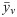
Overview of the available data and our analysis approach.(A) Schematic representation of the bicistronic reporter construct used in [21] with eGFP (green) expression used to measure IRES activity of variable sequences (gray), and constitutively expressed mRFP used to control for unique genomic integration. To capture context effects, in our analyses the assayed variable sequences (thick gray) were extended to include flanking regions (solid filling). (B) The available sequences can be divided into 7 groups based on their origin species and location within transcripts. Number of active sequences, i.e. sequences with IRES activity above background levels, and the total number of RNA sequences are shown for each class. (C) Sequences from each of the groups are represented as vectors of sequence k-mer features (UA—orange, AC—green), which are recorded globally and in windows (gray shading). From this large set of features, those unlikely to be predictive are removed based on their weak correlation with IRES activity. Surviving features are used to construct a reduced feature matrix. (D) The reduced feature matrix is used for Random Forest training. Each RF tree consists of decision nodes (coloured according to the variables selected by those nodes during training) and leaf nodes that predict IRES activity (coloured according to their prediction). RF trees are constructed by iteratively selecting for each node a variable and split that yield the highest reduction in weighted variance in the nodes children; normalised variance reduction is shown for every node as a number. (E) Trained RFs are used to make IRES activity predictions for feature vectors x of unseen sequences by following each tree to the leaf node corresponding to x (path and leaves marked in red), and accumulating leaf node predictions to obtain the overall RF prediction f(x). (F) To select features that are most predictive of IRES activity, variance reduction values from (D) are accumulated per tree and averaged across trees to obtain feature importance. Normalised importance is also calculated for use in model interpretation. (G) To understand the effect of a feature (e.g. the AC k-mer), for each of its possible values v the expected prediction y¯v is plotted (blue curve). The resulting curve allows for characterising v either as having a positive (increasing curve, blue), or a negative (decreasing curve, red) effect on IRES activity. Expected predictions y¯v are approximated as the average of predictions made for training samples with the corresponding feature vector components substituted by value v.